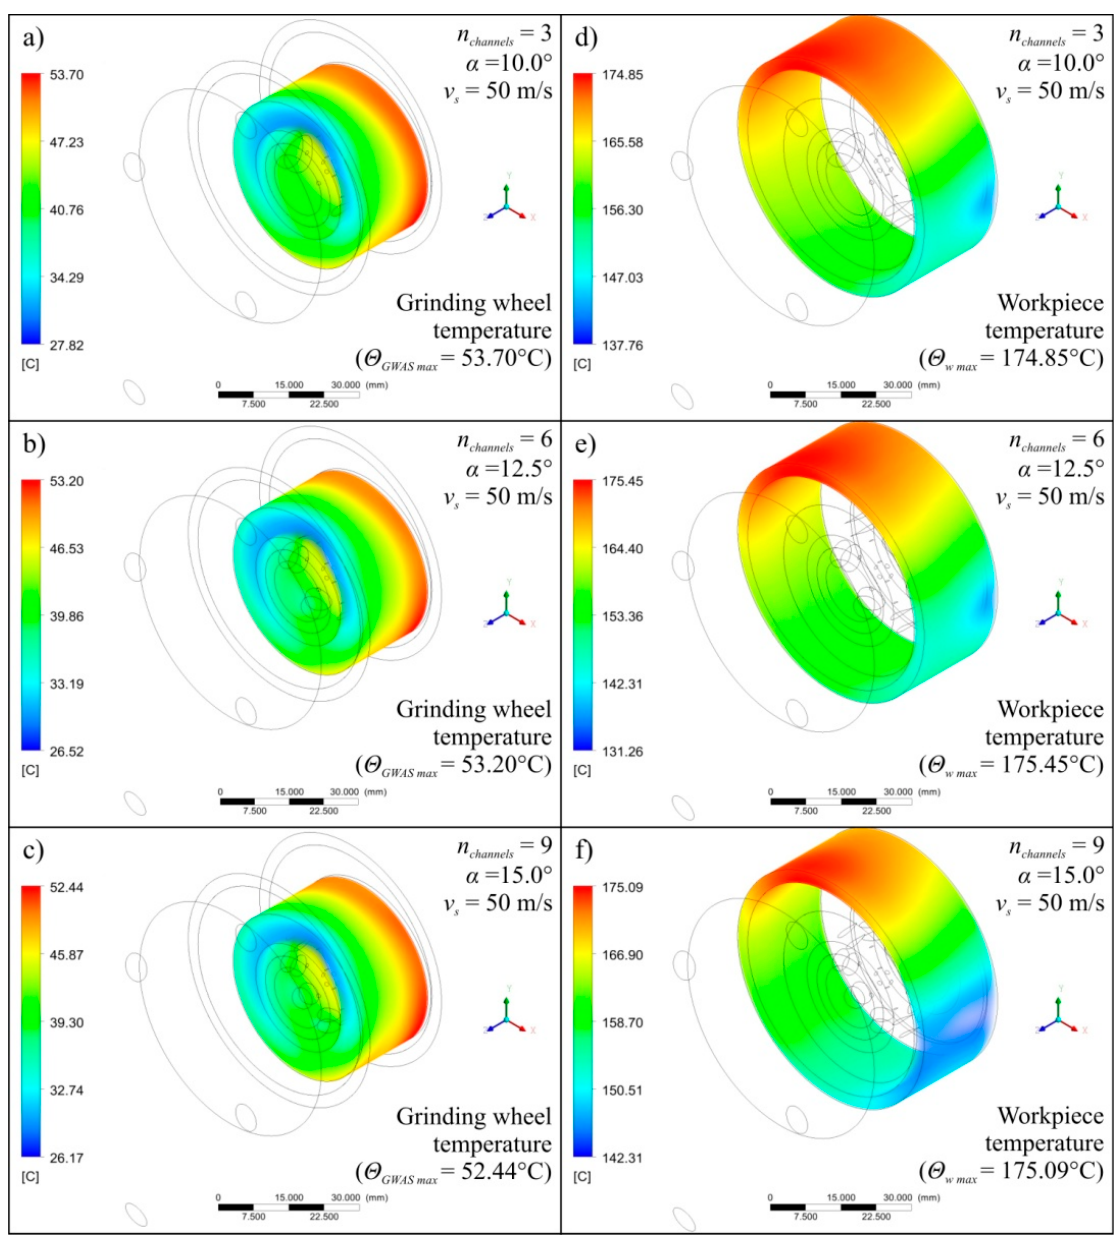
Figure 10. Exemplary simulation results presented as colour maps of grinding wheel temperature ( a , b , c ) as well as oil mist flow velocity ( d , e , f ) for α = 10.0°, n channels = 3, v s = 50 m/s ( a , d ), for α = 12.5°, n channels = 6, v s = 50 m/s ( b , e ) and for α = 15.0°, n channels = 9, v s = 50 m/s ( c , f ).